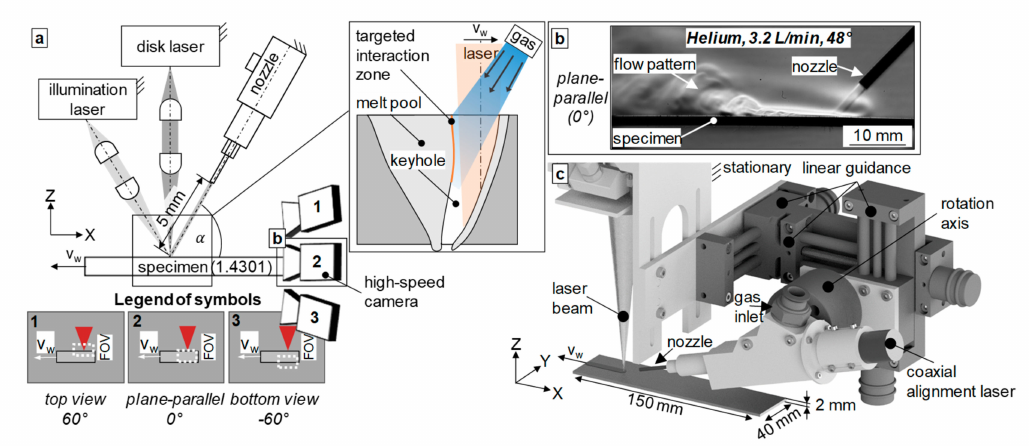
Figure 1. ( a ) Schematic experimental setup; ( b ) Helium flow pattern visualized by schlieren imaging at plane-parallel camera position (0 ◦ ); ( c ) Specs of used gas nozzle unit.